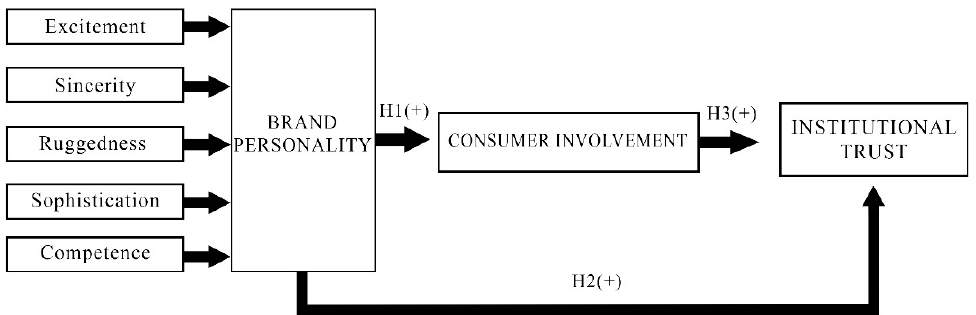
Figure 1. Research model and hypotheses.